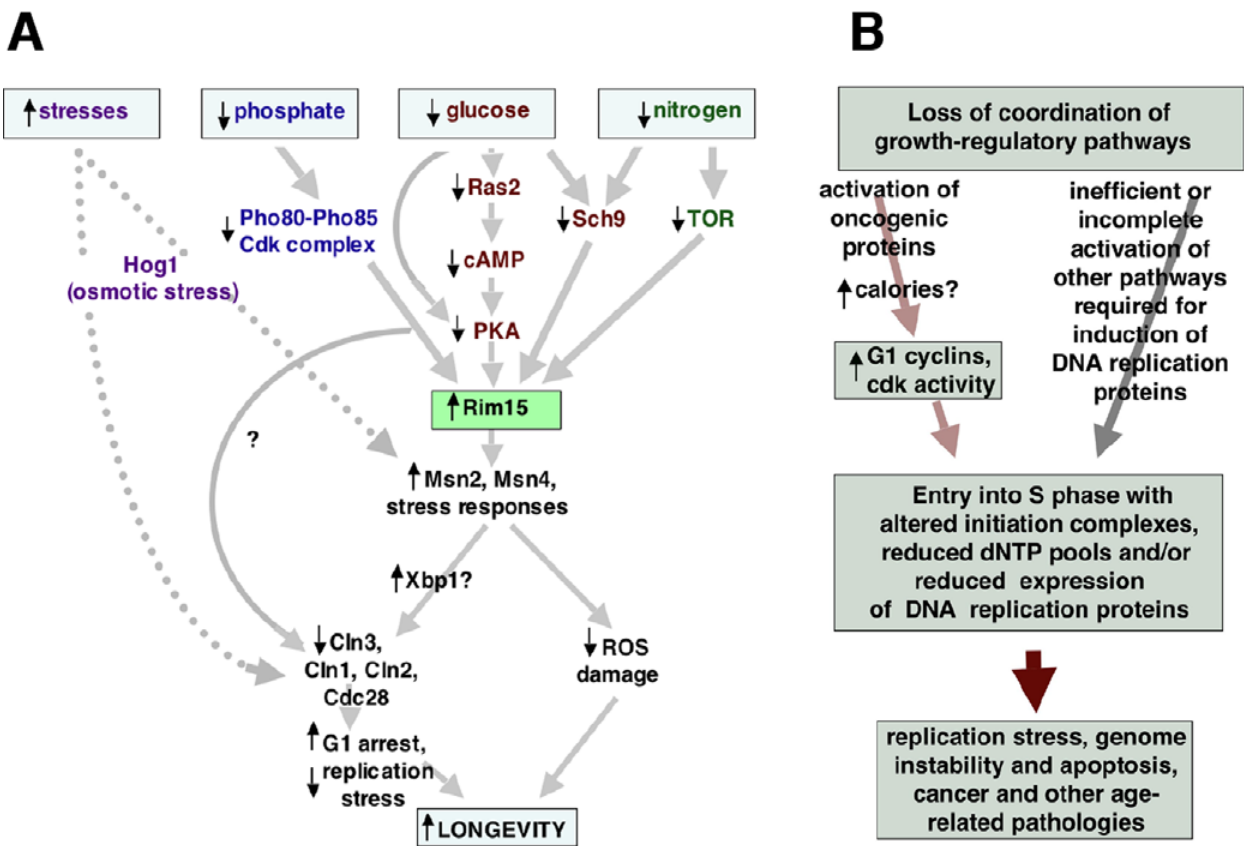
Figure 6. Models for longevity regulation by growth signaling pathways in budding yeast (A) and deregulation of growth regulatory pathways leading to replication stress and aging in all eukaryotes (B). A. In budding yeast, nutrient signaling pathways that respond to glucose, nitrogen and phosphate converge upon Rim15, which is downregulated by signaling through these pathways when nutrients are plentiful. Activation of Rim15 when nutrient signaling is inhibited induces stress response factors (including Msn2 and Msn4) and stress responses mediated by Sod1, Sod2 and other proteins that mitigate oxidative damage and other effects of stresses. Reduced nutrient signaling also downregulates Cln3 and downstream Clns1 and 2, which are required for activation of the cyclin-dependent kinase Cdc28. Inactivation of Cdc28 during nutrient depletion contributes to a G1 arrest that protects against replication stress. Osmotic stress (and perhaps other stresses) also contribute to G1 arrest during nutrient depletion. G1 arrest in response to nutrient depletion and other stresses may be mediated in part by induction of the transcriptional repressor Xbp1, which inhibits Cln transcription. Enhancement of G1 arrest by caloric restriction, osmotic stress or mutational inactivation of nutrient signaling pathways protects against replication stress and promotes longevity in combination with Rim15-dependent responses to oxidative-and other stresses. B. Replication stress associated with uncoordinated entry into or exit from S phase downstream of the activation of some, but not all, growth signaling pathways may be an important factor determining lifespan in all eukaryotes. In both panels, question marks indicate hypothetical or